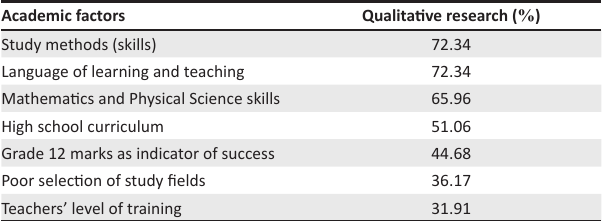
TABLE 2: Qualitative responses related to academic